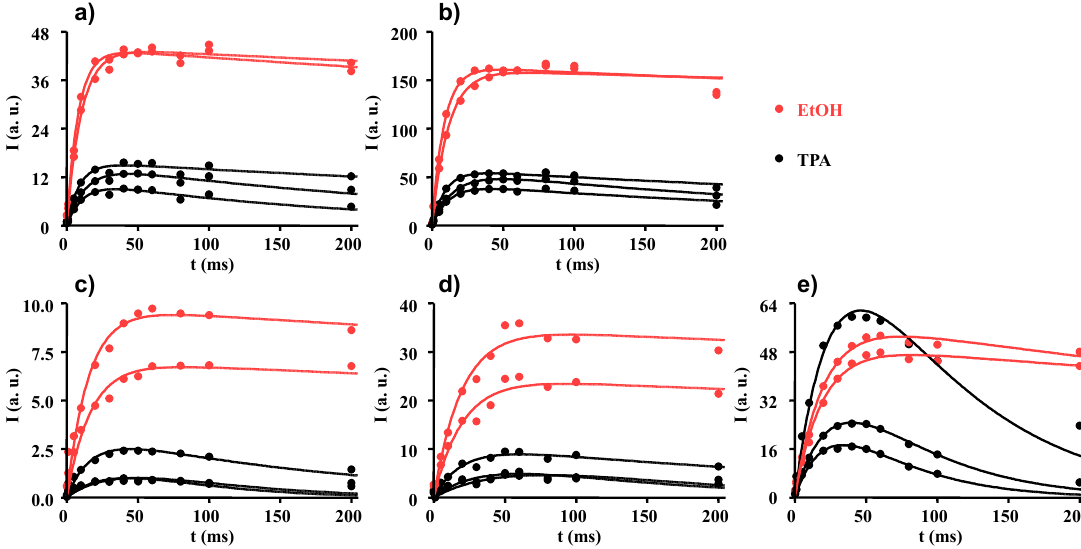
Figure 7. Staggered view of the successive NMR spectra in the 1 H → 13 C CP experiment as a function of contact time ( t ct ) of the precursor sol (S) with the molar composition 25 TEOS:9 TPAOH:400 H 2 O/D 2 O. The two intense resonances at ca. 17 and 57 ppm correspond to EtOH and the three weak resonances at 10, 15, and 60 ppm to TPA cation.